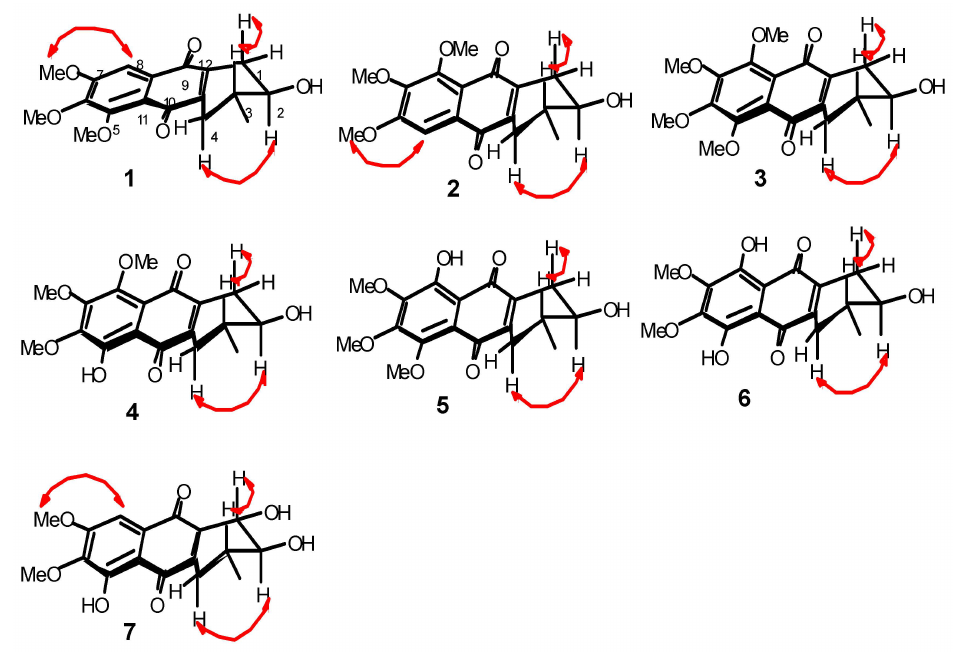
Figure 3. Key ROESY (red arrows) correlations of 1 – 7 . Table 1. 13 C-NMR data for prisconnatanones C ´ I ( 1 ´ 7 ) a